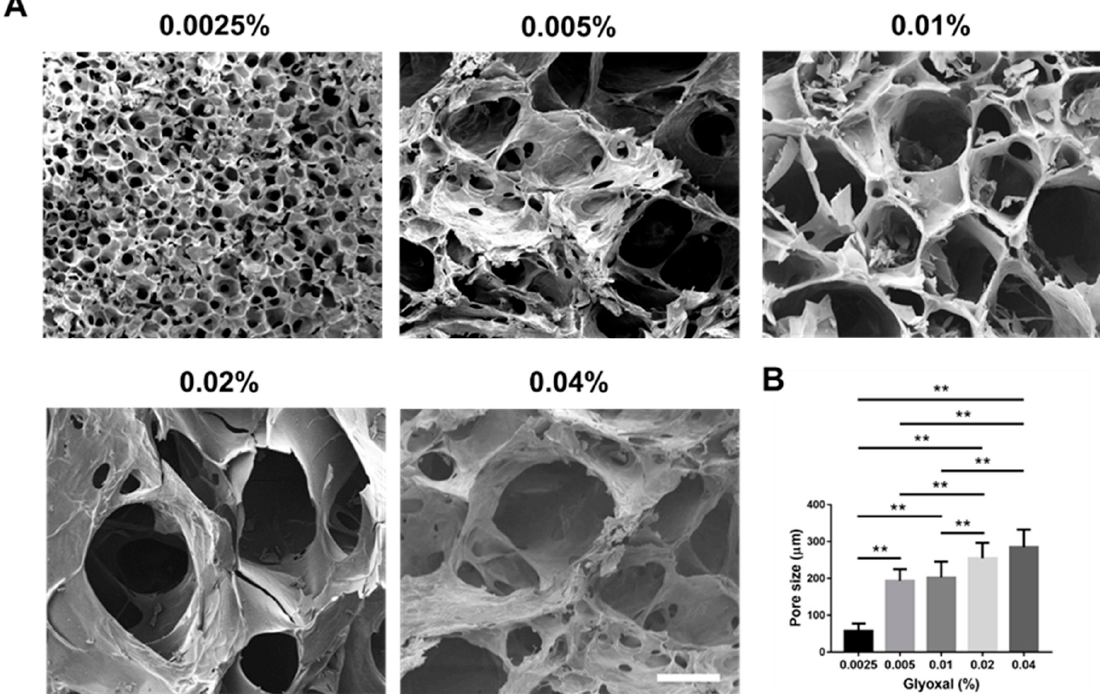
Figure 4. The porosity of CS-GE hydrogels crosslinked with different glyoxal concentrations. ( A ) The representative scanning electron micrographs of lyophilized CS-GE hydrogels crosslinked with different concentrations of glyoxal (scale bar = 200 μ m). ( B ) Pore size measurement revealed significant differences among different CS-GE hydrogels. (* p < 0.05, ** p < 0.01).